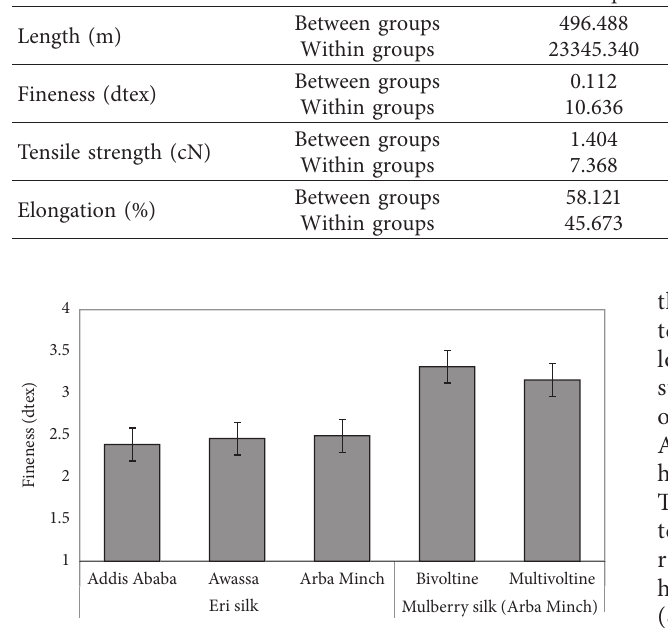
Figure 5: Fineness of silk